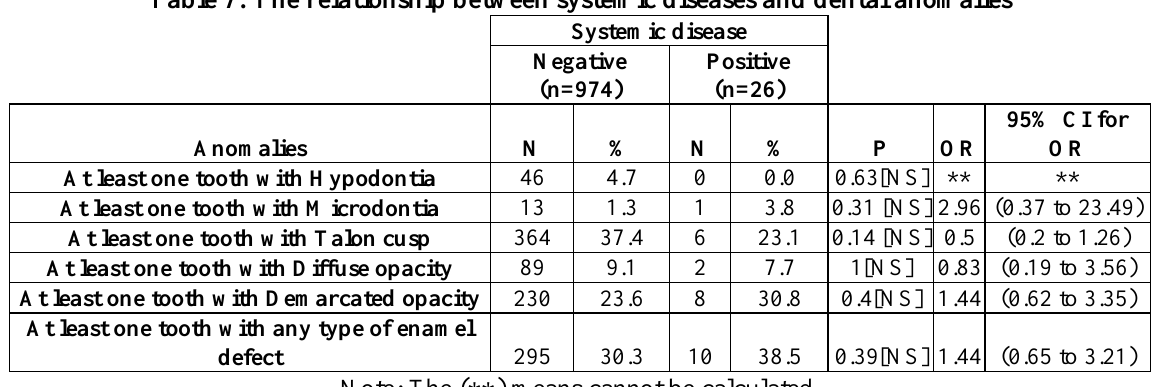
Table 7: The relationship between systemic diseases and dental anomalies